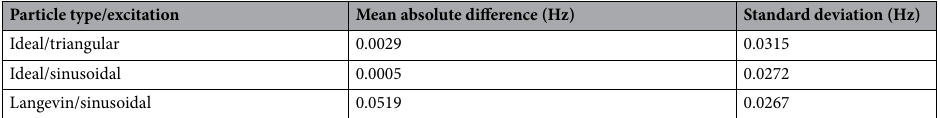
Table 1. Validation of theoretically derived frequency shifts by simulation. Mean and standard deviation of the absolute differences | � f theo ( v s ) − � f sim ( v s ) | of derived frequency shifts by theory and simulation.